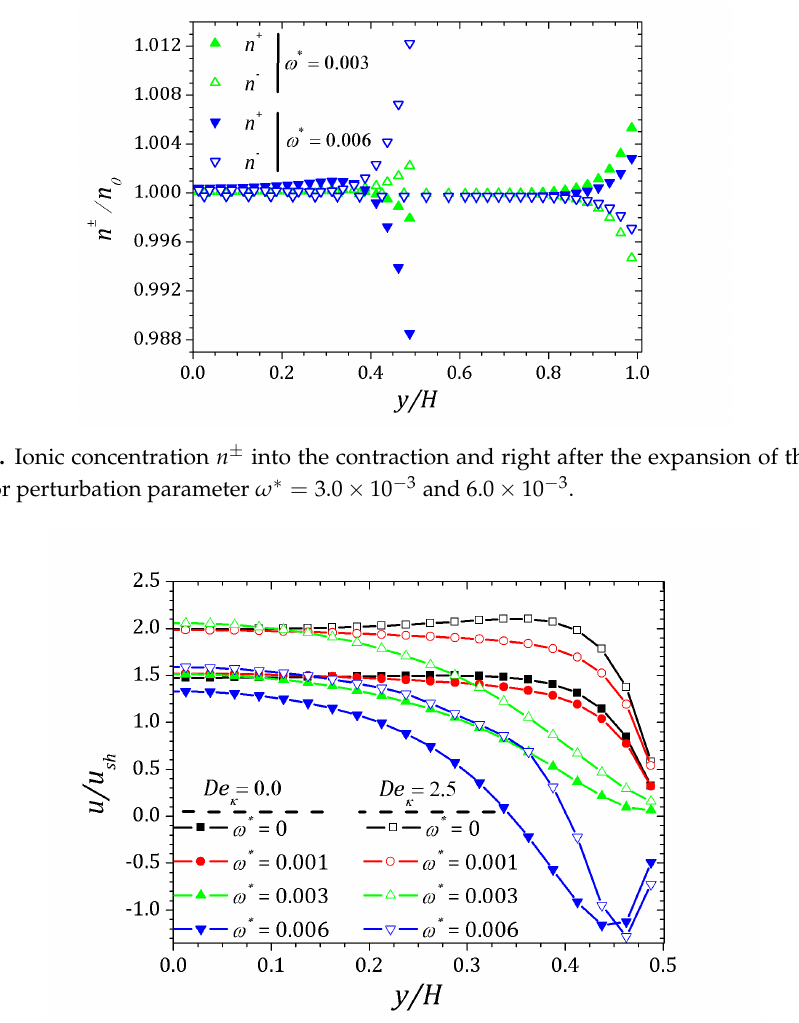
Figure 24. Perturbation effect on the velocity profile for sPTT model. Results for De κ = 2.5, ε = 0.1 and